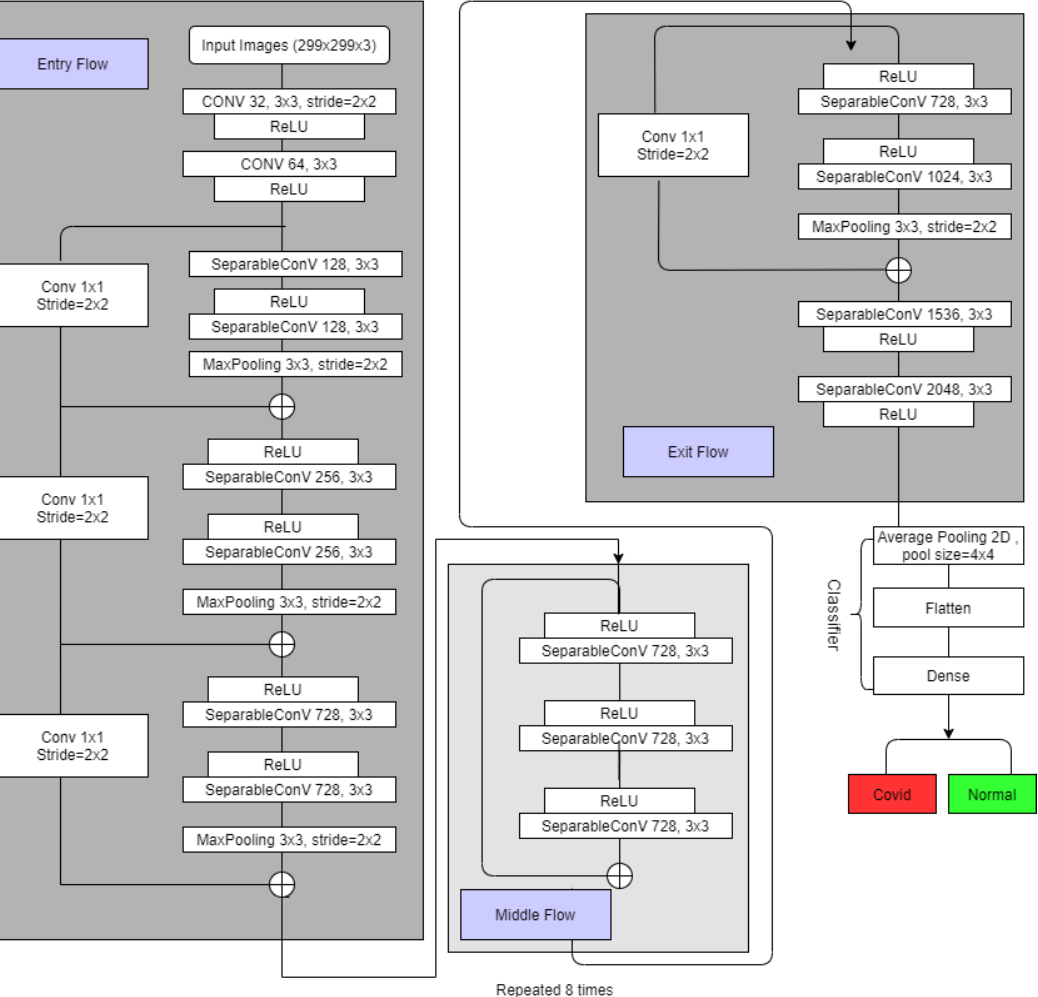
Figure 7. Modified Xception Network to Classify COVID and Normal images. For the four classes, similar architecture is applied and the final dense layer has an output size of four to detect normal, COVID, Lung Opacity and non-COVID viral pneumonia